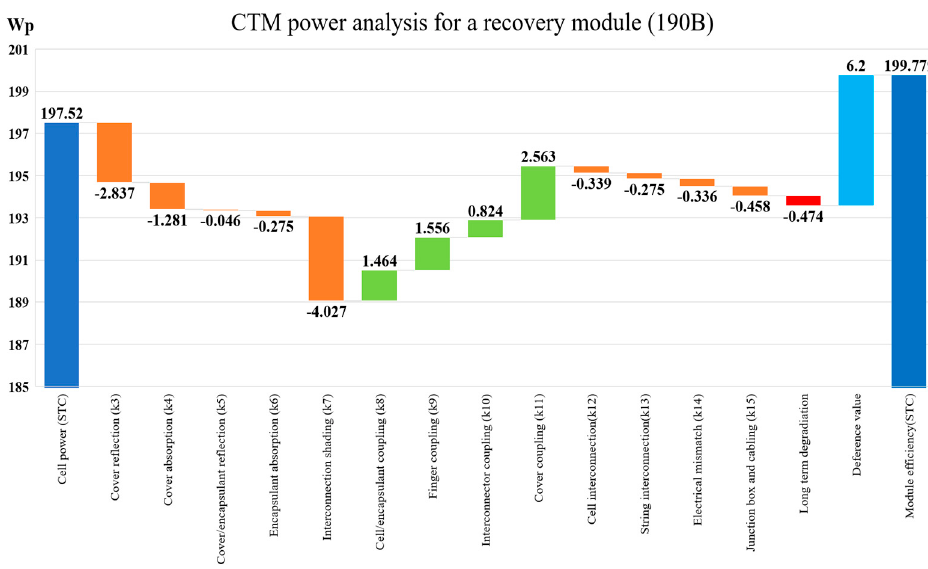
Figure 10. CTM power analysis for a recovered module (190 B).